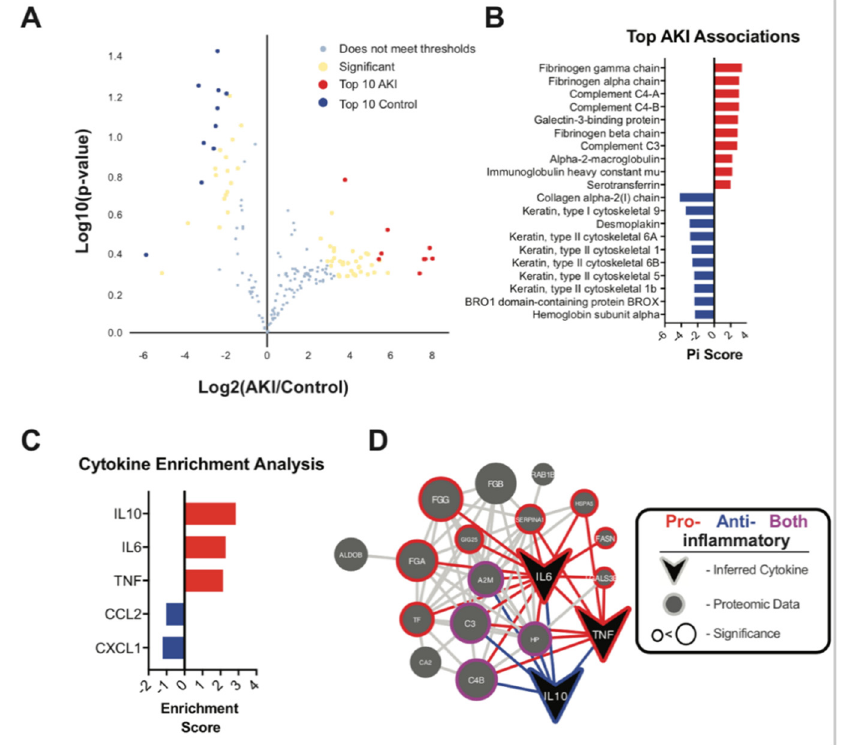
Figure 5. Protein-level Associations to V-AKI. ( A ) Volcano plot displaying the fold-change and t -test significance of each protein to V-AKI status. The top 10 proteins associated with AKI and control status are shown in blue and red respectively. Other associated proteins based on a Pi Score > 1 are shown in yellow. ( B ) A Pi score, which accounts for both fold-change and t -test significance was calculated for each protein and the proteins with the strongest associations are plotted. ( C ) Top cytokines associated with AKI or control proteins. A network-based cytokine inference approach was taken and the cytokines showing the strongest enrichment scores toward either AKI or control-associated proteins are shown. Red bars represent cytokines related to AKI-associated proteins, blue bars represent cytokines related to control-associated proteins. ( D ) Protein-protein interaction network of AKI-associated proteins and AKI-enriched inferred cytokines. The outer edge of protein nodes is colored dependent upon associations to pro or anti- inflammatory cytokines. The size of each node represents the strength of the statistical association of each protein to AKI